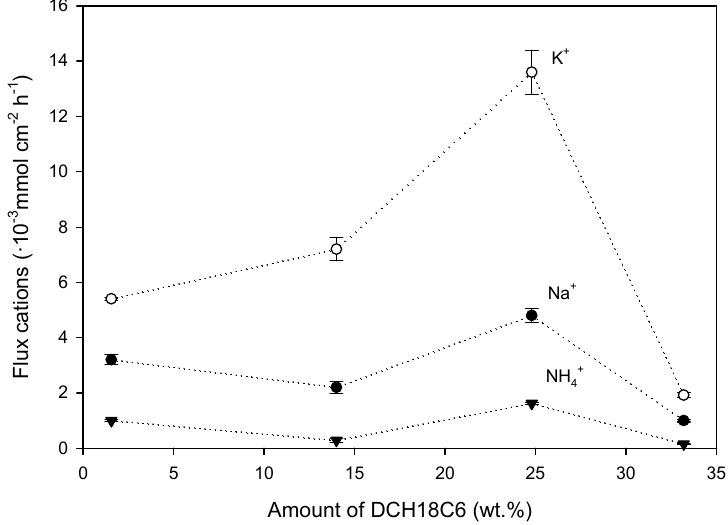
Figure 3. Effect of DCH18C6 content on the flux of the optimized PIM after 50 h. Results correspond to PIM-6 (1.56 wt %), -7 (14.0 wt %), -8 (24.8 wt %) and -9 (33.2 wt %).